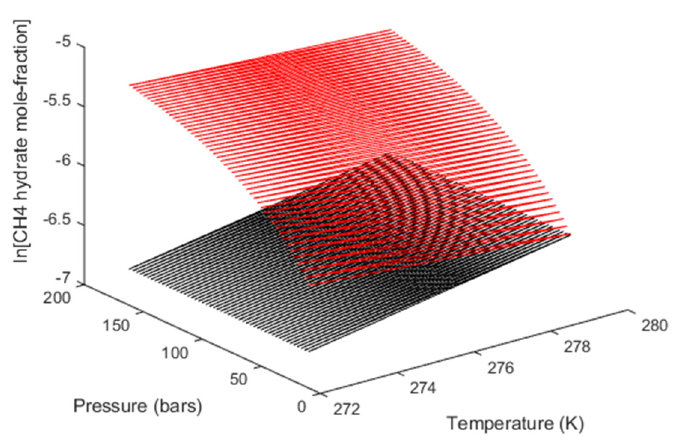
Figure 4. Calculated stability limits for hydrate towards CH 4 content in surrounding water (black). Red contour is solubility mole-fractions of CH 4 in water.